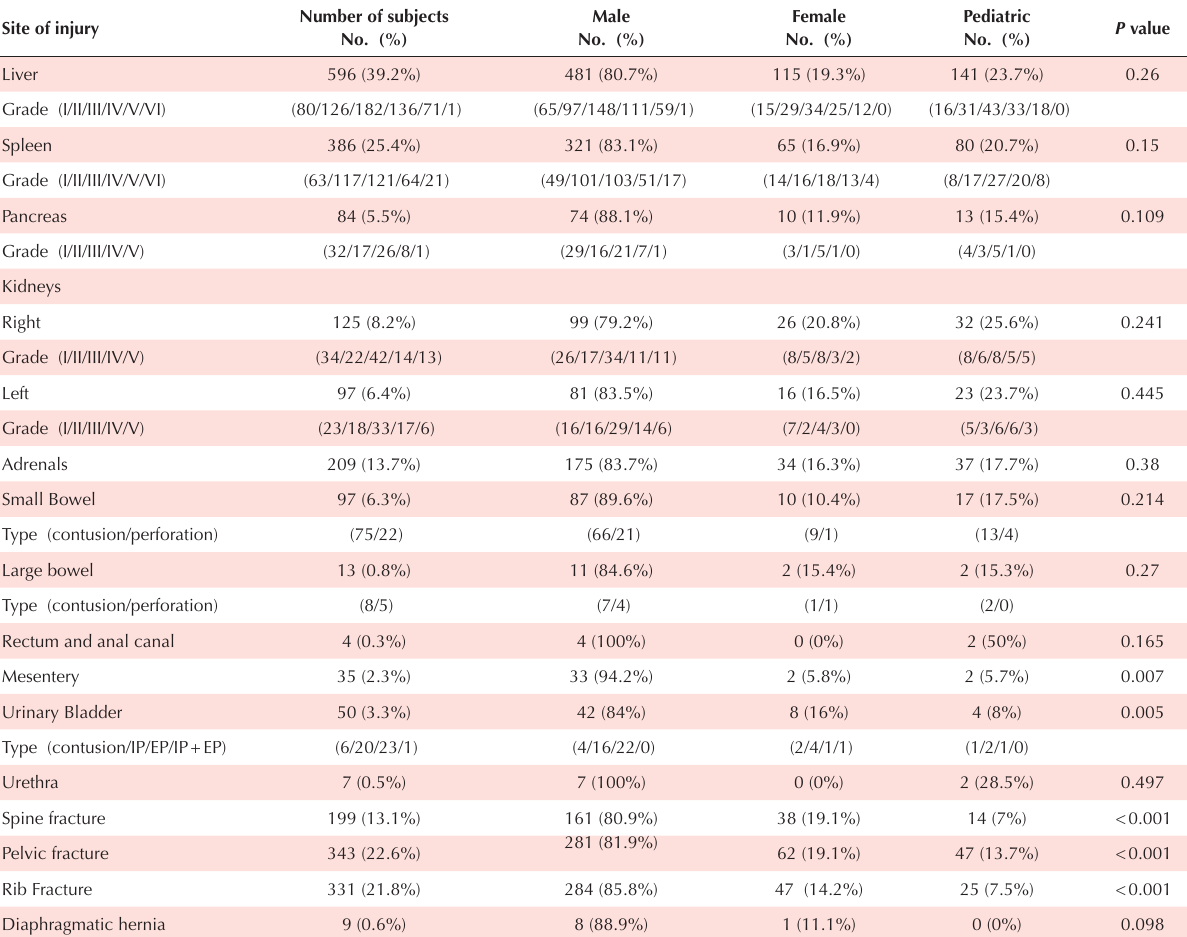
Table 2. Location, extent and demographic distribution of the